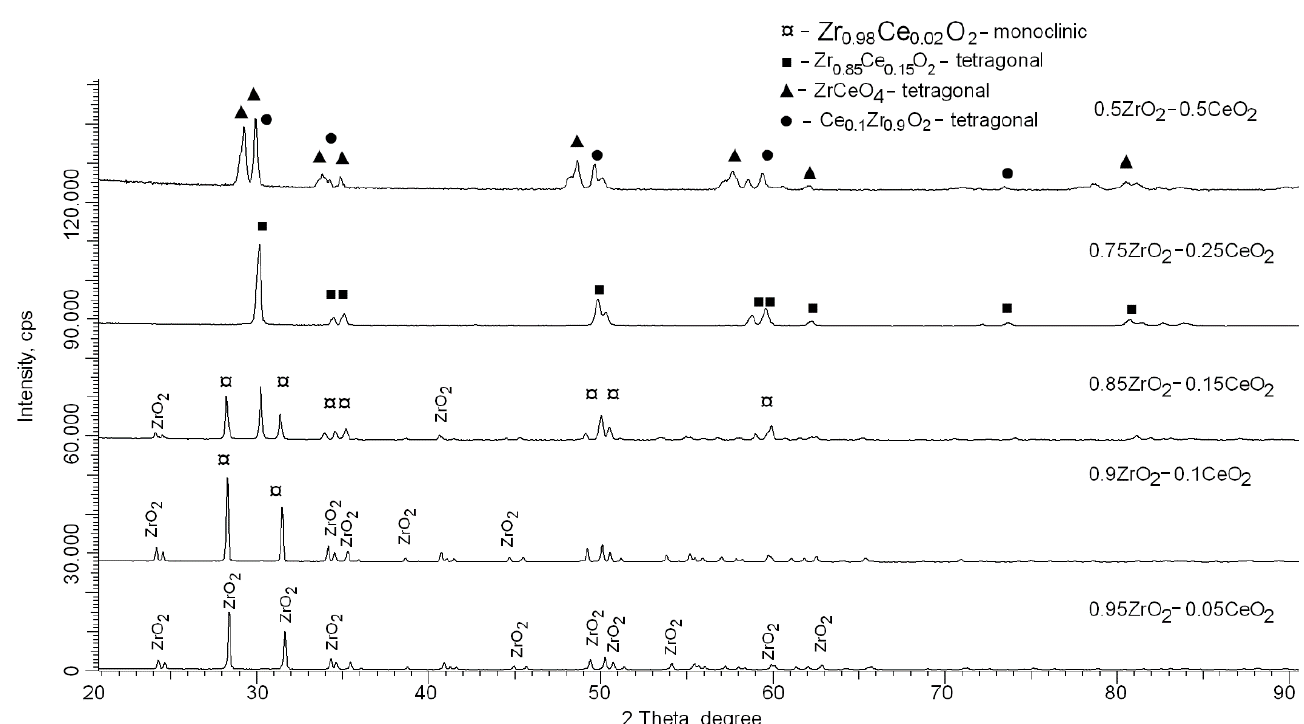
Figure 1. The results of SEM images of (1 − x)ZrO 2 − xCeO 2 ceramic grains depending on the concentration of CeO 2 in the composition: ( a ) 0.05; ( b ) 0.10; ( c ) 0.15; ( d ) 0.25; ( e ) 0.50; ( f ) mapping results of the 0.5 ZrO 2 –0.5 CeO 2 sample reflecting the isotropic distribution of zirconium and cerium in the structure of ceramics.